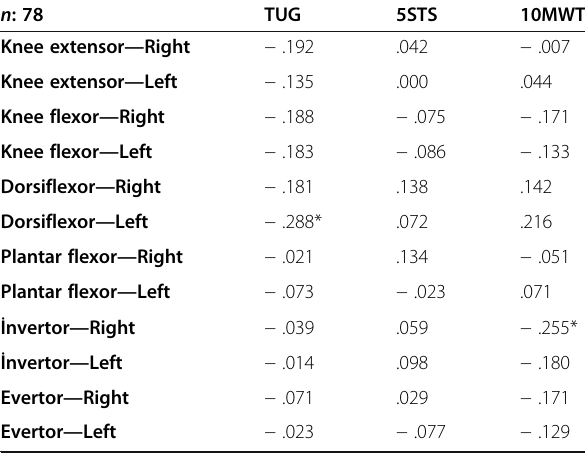
Table 3 The relationship between the average knee-ankle muscle strength and performance test